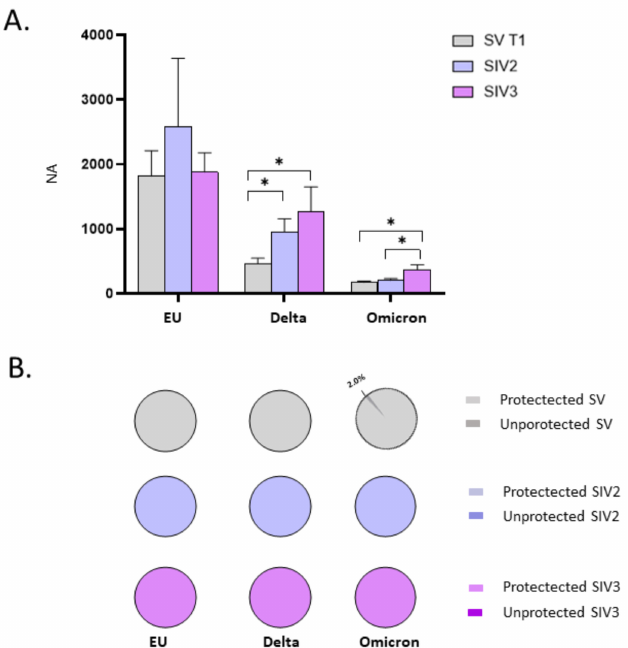
Figure 4. Comparison of neutralizing activity (NA) in plasma specimens from SARS-CoV-2 Infected after 2 (SIV2), or 3 doses of Vaccine (SIV3) and SARS-CoV-2 Vaccinated subjects (SV) at T1. NA in plasma from SIV was higher than in SV against all the examined VOCs ( A ). Pie charts show the percentage of SV (grey), SIV2 (light blue), and SIV3 (lilac) lacking NA against the EU, Delta, and Omicron variants, respectively ( B ). * p <